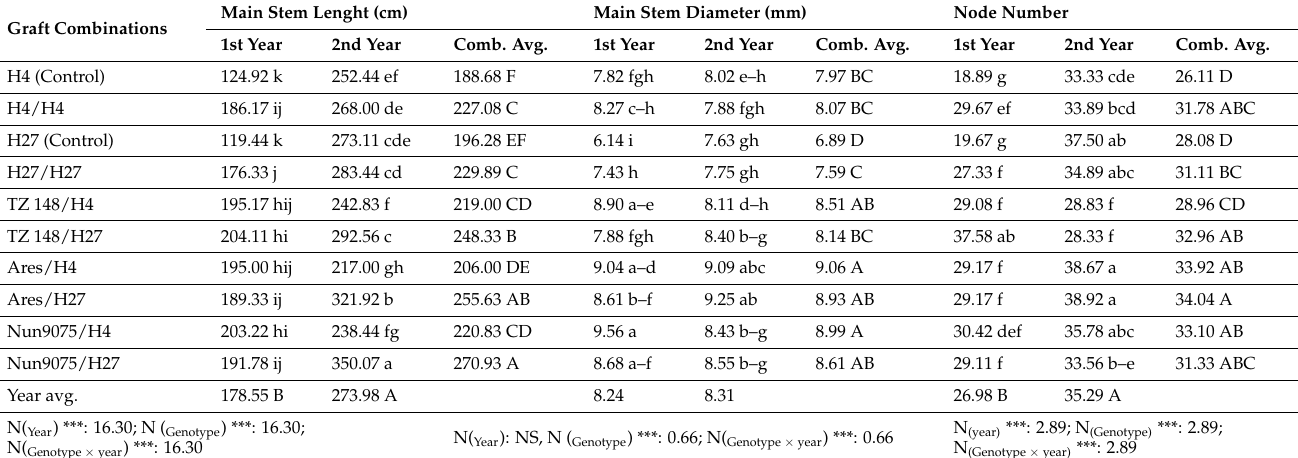
Table 2. Main stem length, main stem diameter and node number in both